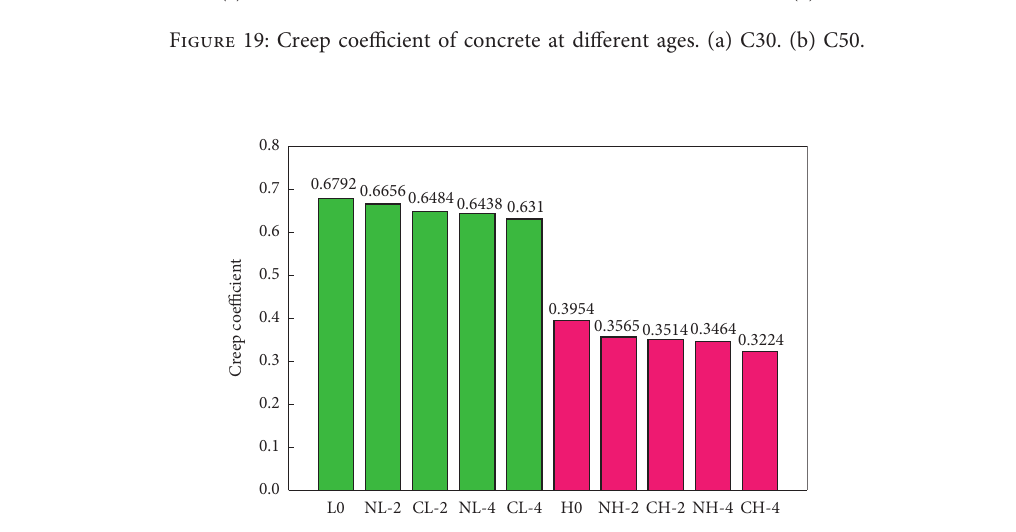
Figure 20: Creep coefficient of concrete at the age of